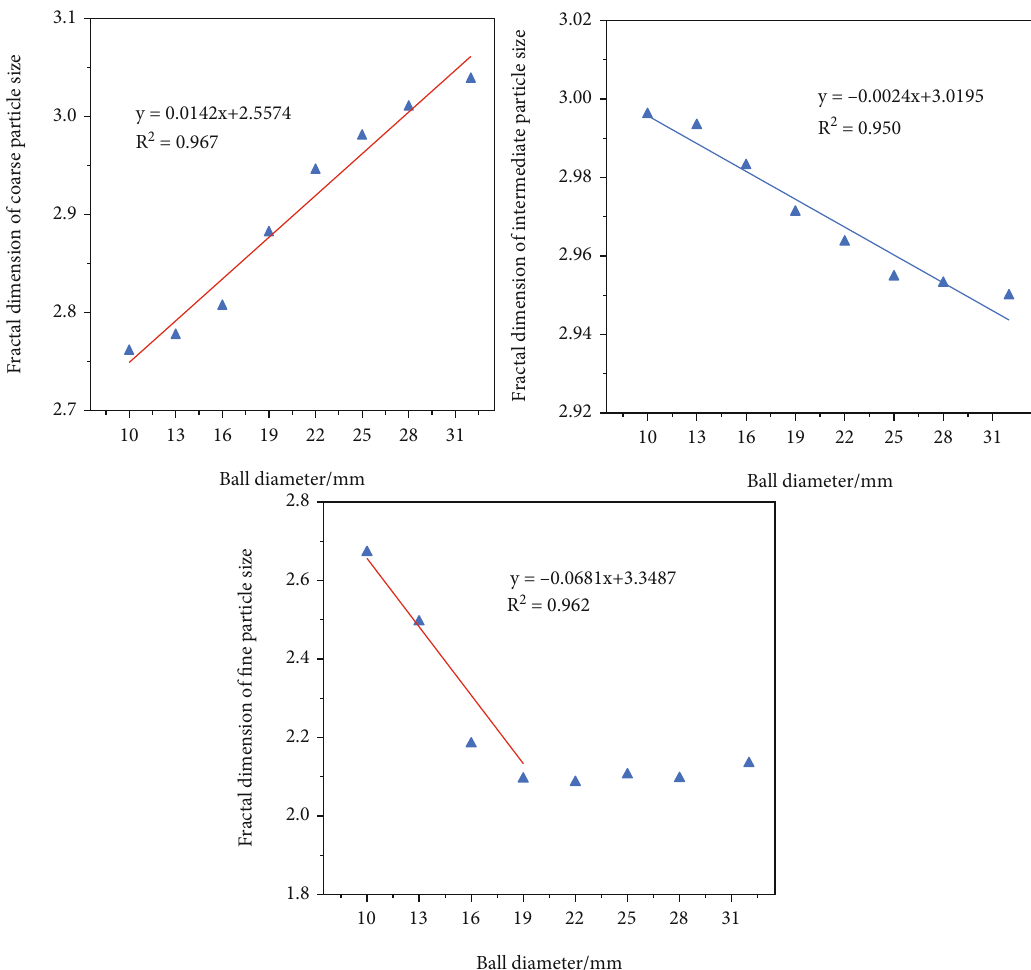
Figure 5: The relationship between the steel ball sizes and the fractal dimensions of di ff erent particle size distribution by